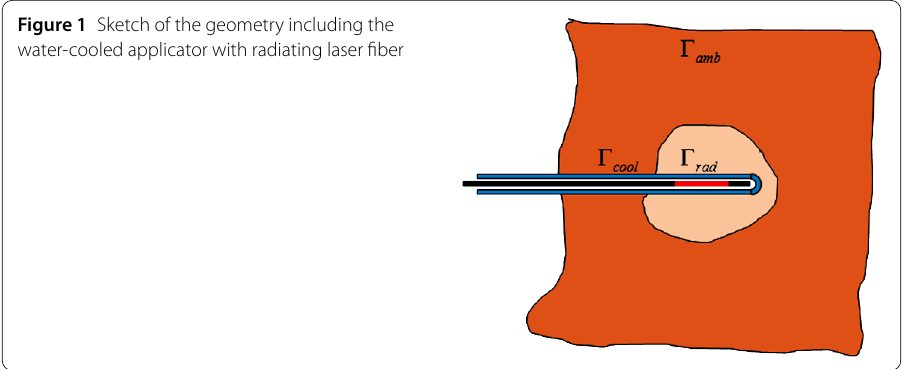
Figure 1 Sketch of the geometry including the water-cooled applicator with radiating laser